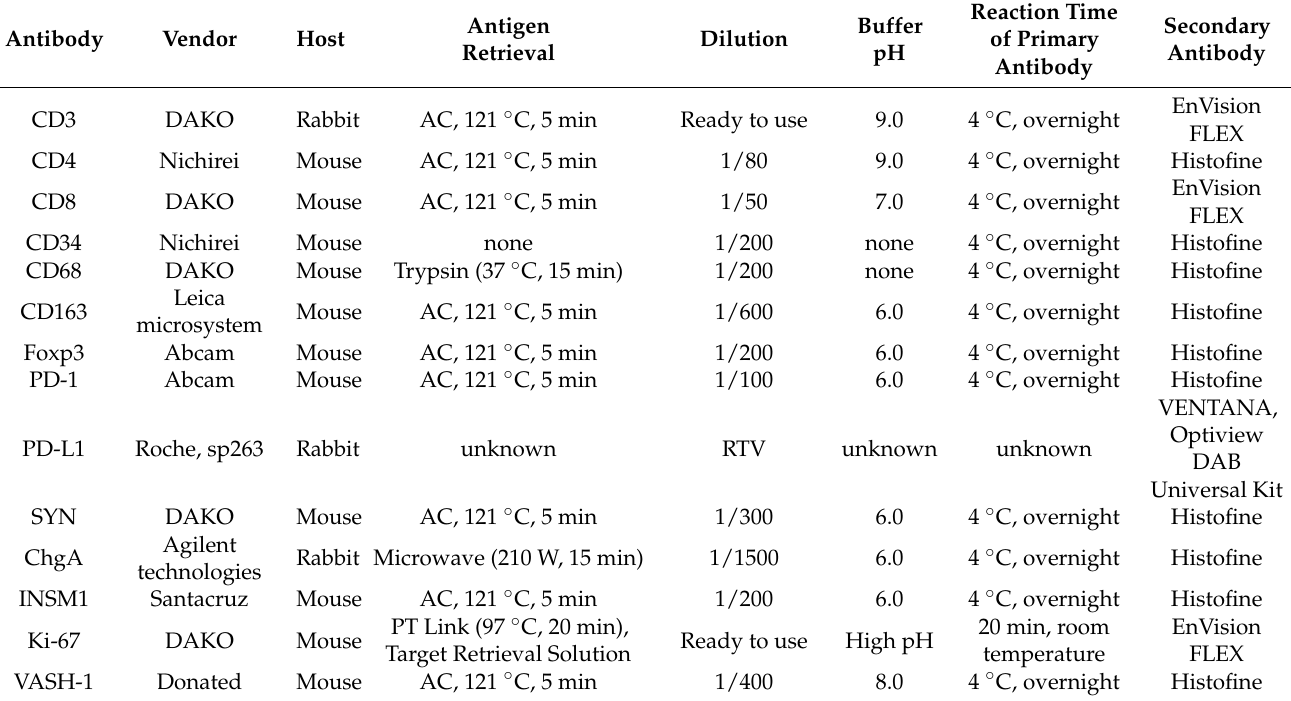
Table 2. Summary of the immunohistochemistry protocols used in this